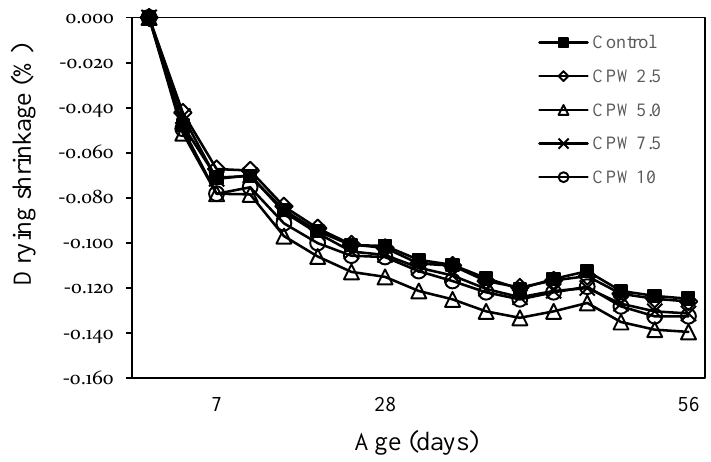
Figure 10. Drying shrinkage of samples.